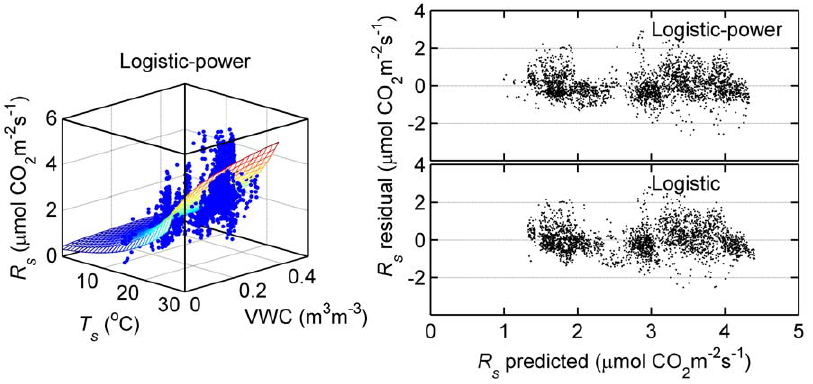
Figure 6. Soil respiration ( R s ) as a function of soil temperature ( T s ) and soil water content (VWC). Mesh is fitted using logistic-power function in table 3 and right panel is comparison of R s residuals from logistic-power and logistic functions.